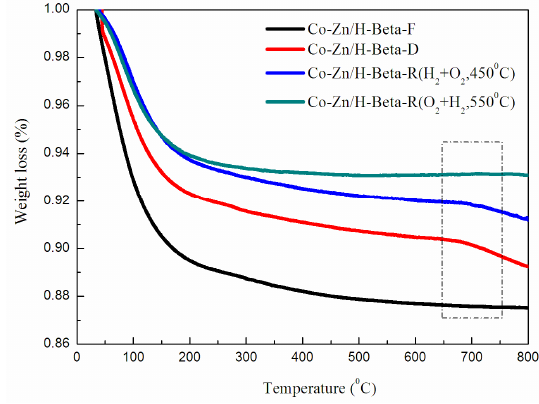
Figure 8. TGA curves of fresh, deactivated, and regenerated catalysts.